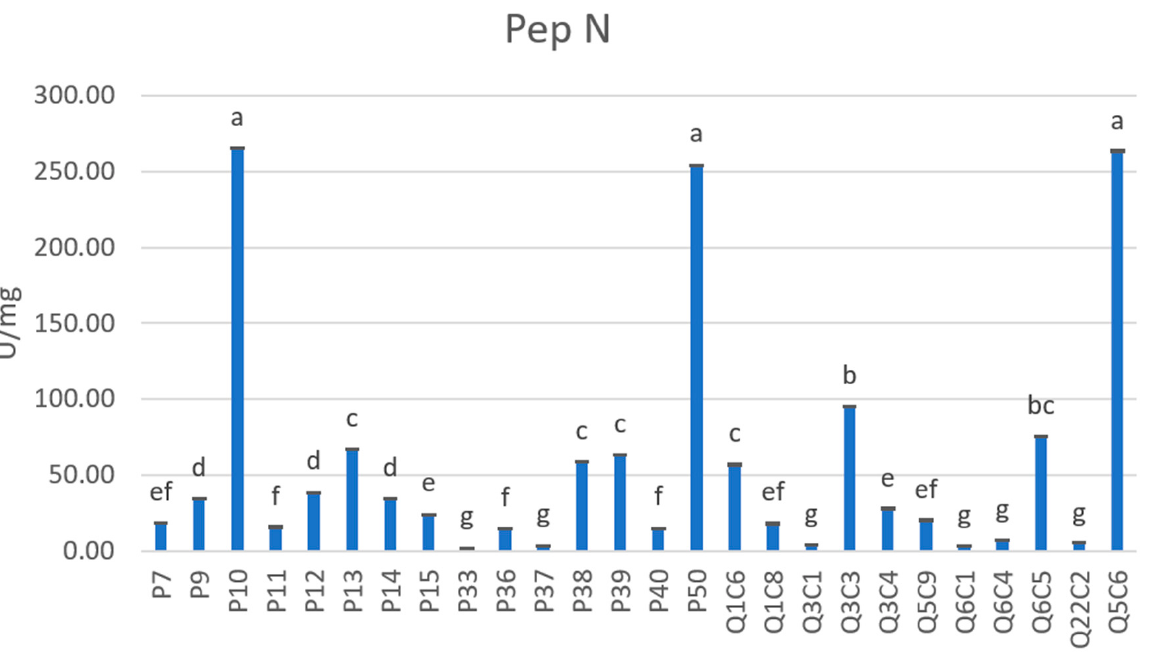
Figure 2. Aminopeptidase N (Pep N) activity exhibited by the tested strains. Results are reported as mean and standard deviation of three replicates. Aminopeptidase activity was expressed as the number of activity units per milligram of protein per minute (U/mg). One unit of aminopeptidase activity was considered as the amount of enzyme required to release 1 µ mol of p-NA per minute under the assay conditions. Different letters (a–g) indicate statistically significant differences as determined by the one-way ANOVA test, which is followed by the Tukey’s post-hoc test ( p < 0.05). Overall, it is well known that aminopeptidase activity is crucial for the breakdown